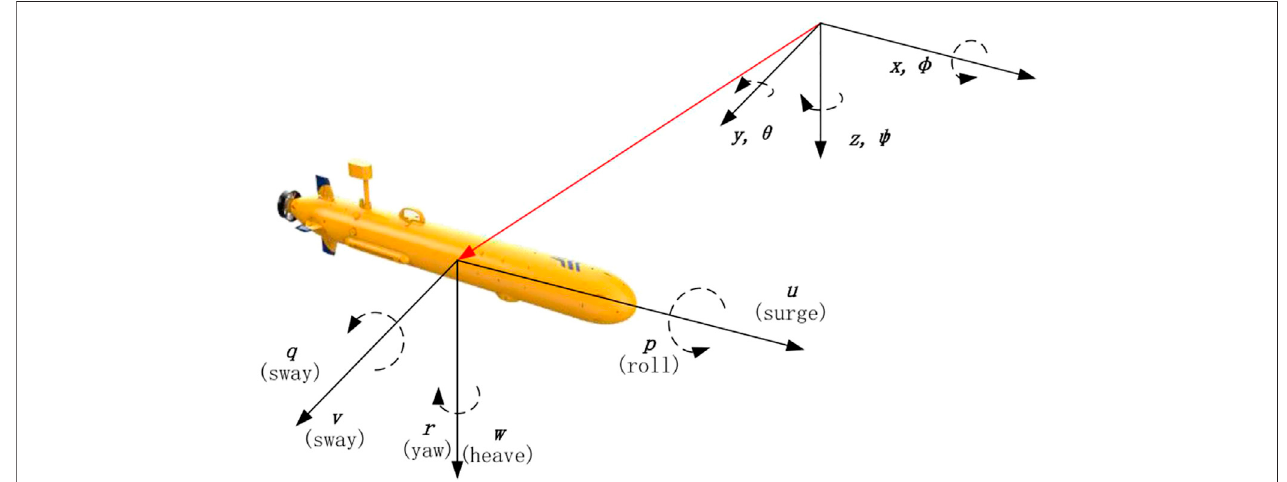
FIGURE 1 | Model diagram of AUV in inertial and fi xed coordinate systems.